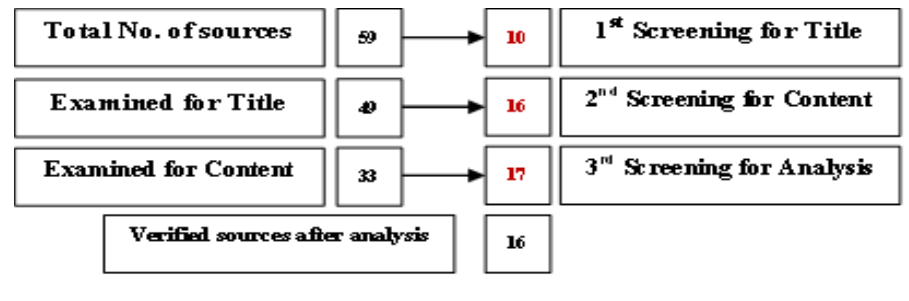
Figure 1. Screening analysis process of research tailored to the research purpose to identify